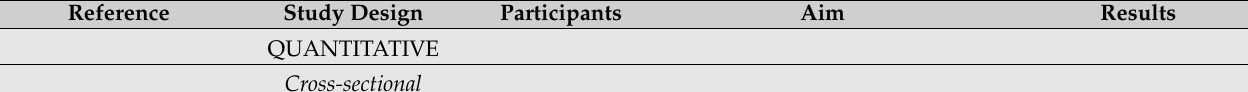
Table A3. Articles included in the third category: